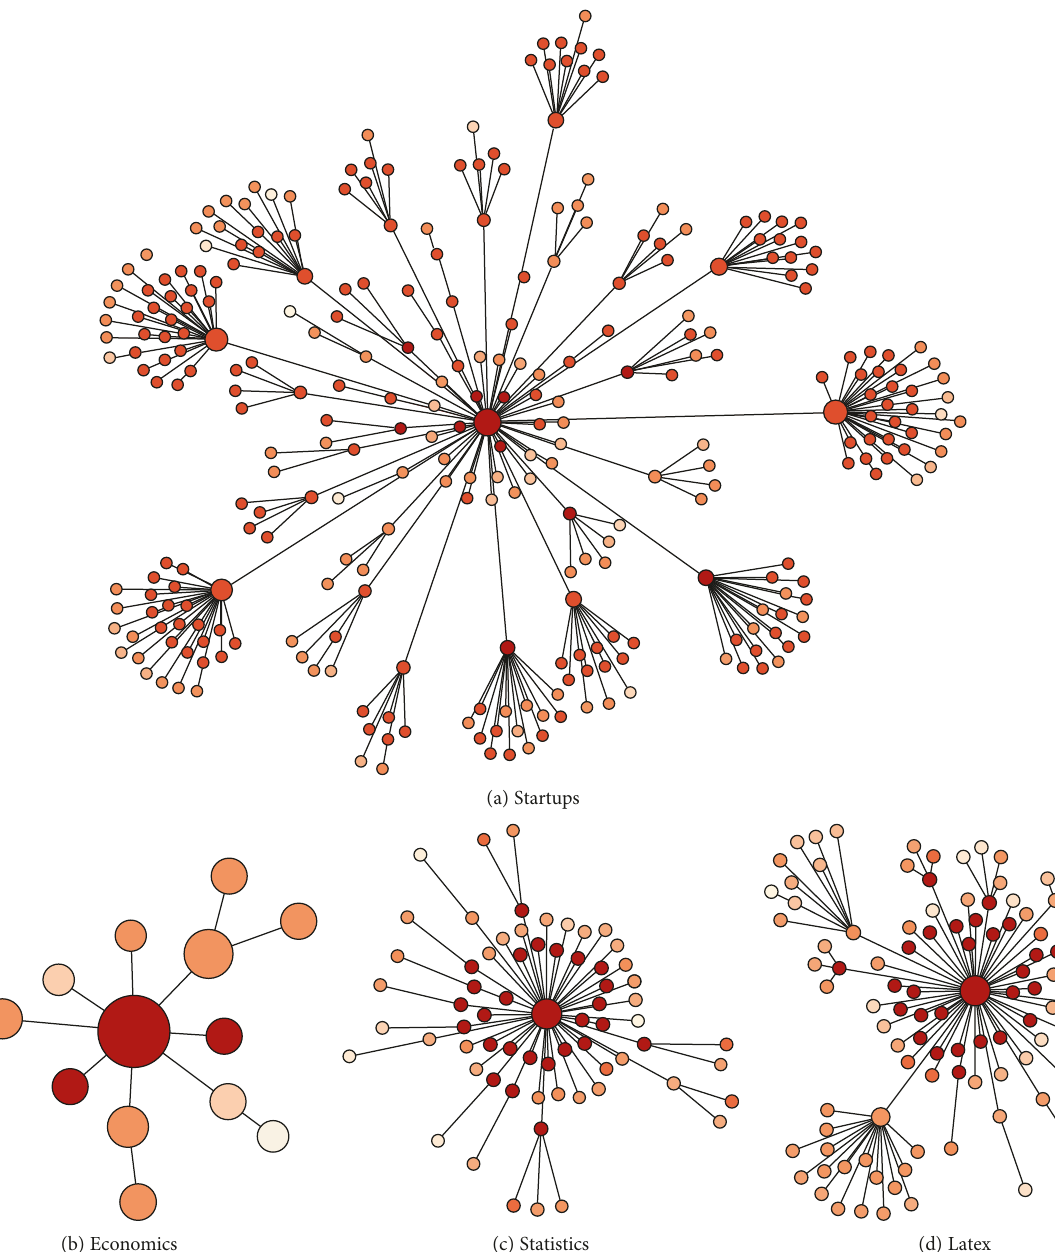
Figure 1: The largest cascades extracted from the datasets. The color of the node is inversely proportional to the time at which the node became inactive (i.e., the darker the node, the earlier it became inactive), and the size of a node is directly proportional to its degree in the